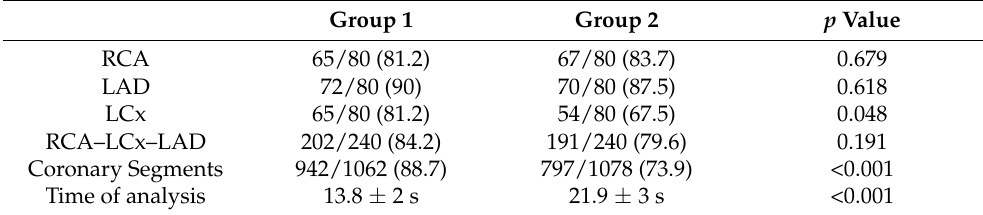
Table 2. Software performances.